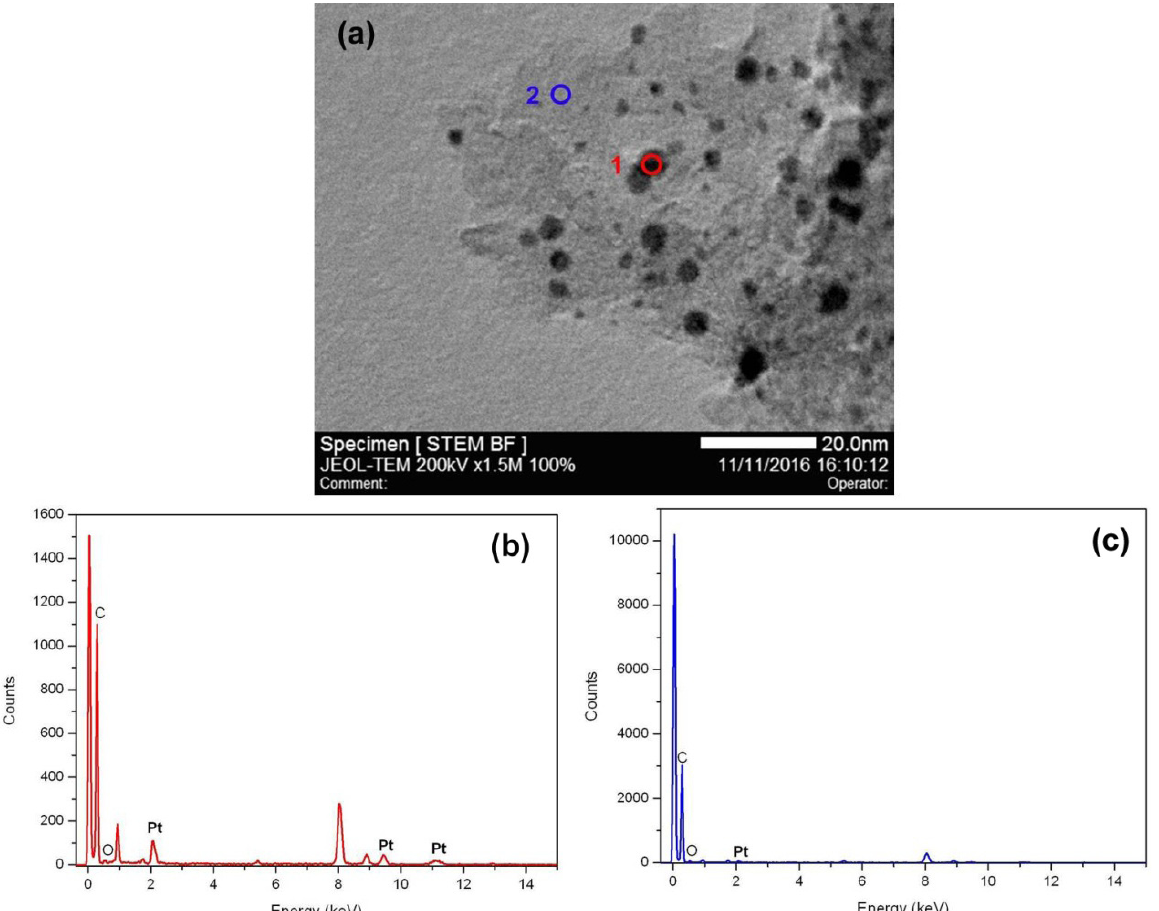
Figure 3: (a) Bright field STEM image of the Pt/C catalyst; (b) Corresponding EDX elemental analysis from area 1 (red circle) in the STEM image; (c) Corresponding EDX elemental analysis from area 2 (blue circle) in the STEM